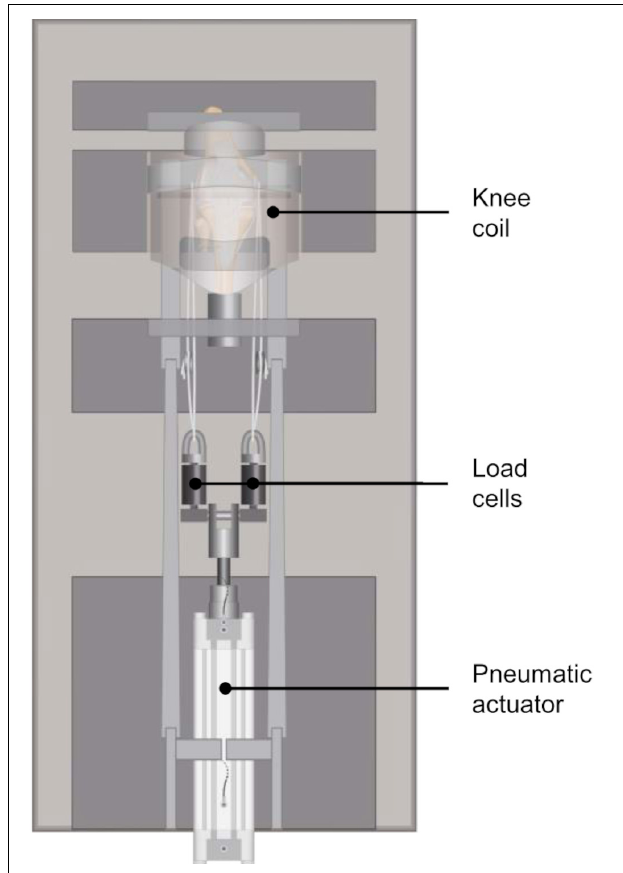
FIGURE 1 | Schematic representation of the modified MRI-compatible loading apparatus introduced by Freutel et al. (2014), equipped with two axial load cells for controlled application of the axial load on the lateral and medial knee